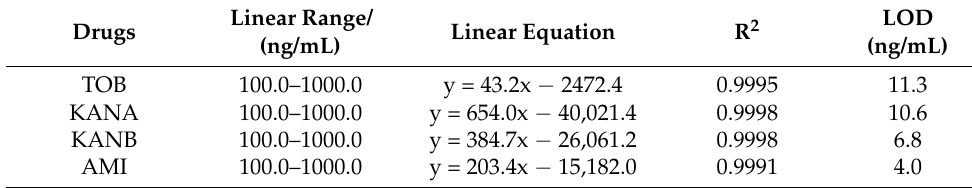
Table 4. Linear equations of four kinds of AGs.